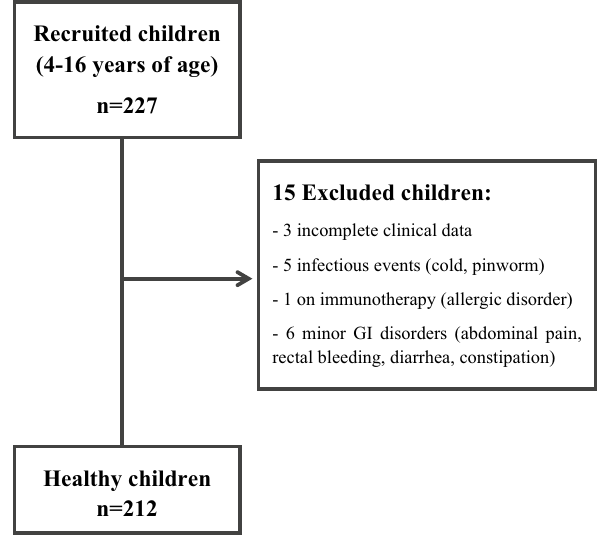
Figure 1. Flowchart.